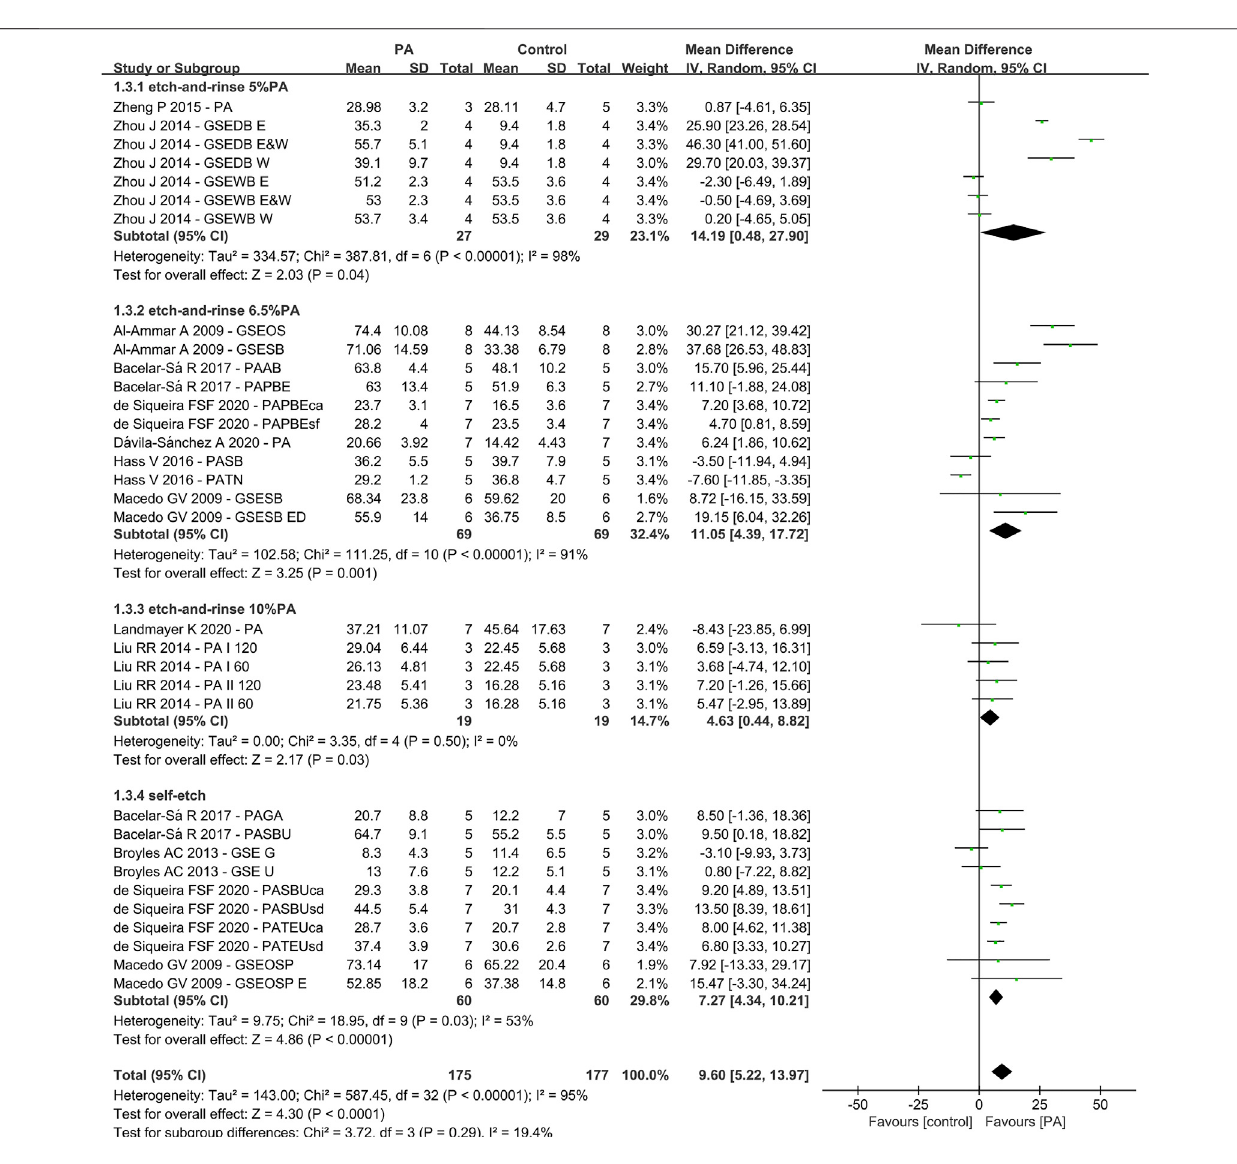
Frontiers in Bioengineering and Biotechnology |